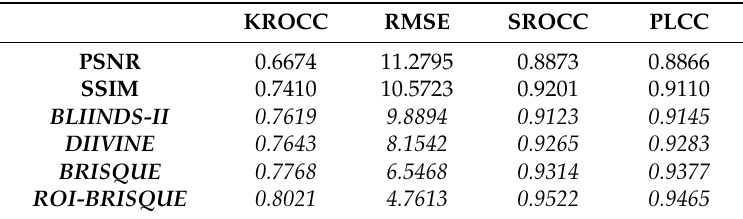
Table 4. Performance comparison of some IQA methods and the method of this paper. Italicized algorithms are NR IQA algorithms, others are FR IQA